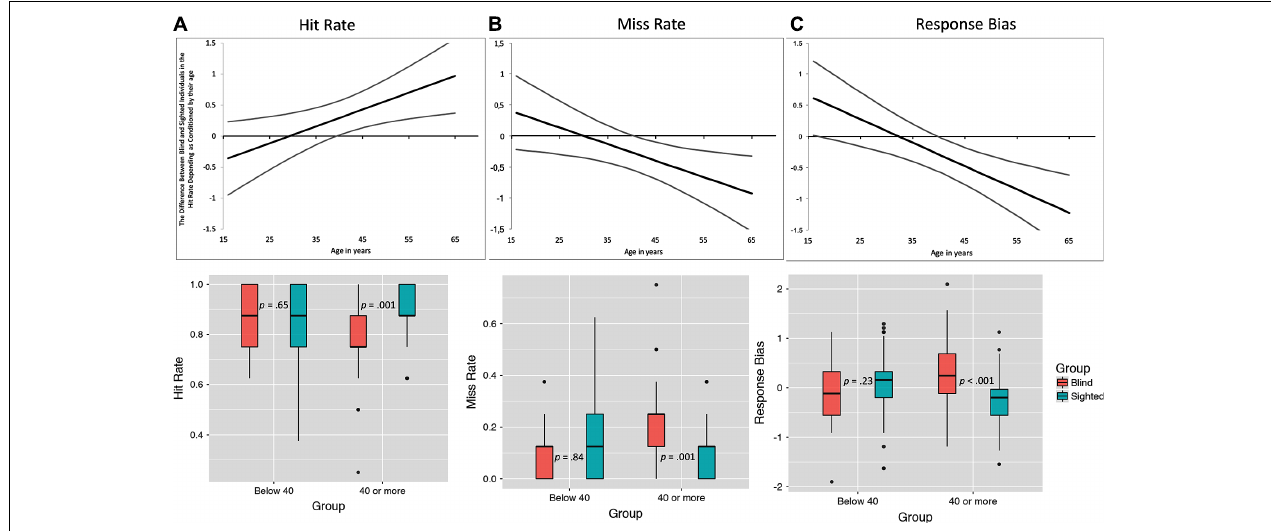
FIGURE 3 | The difference between blind and sighted individuals in hit and miss rates as moderated by their age. Top panels illustrate the zone of significant interaction estimated using the Johnson-Neyman technique. Gray lines are 95% confidence intervals – in the cases if both intervals do not cross X Axis, the moderation effect is statistically significant. Lower panels illustrate the difference between blind and sighted individuals below and above the age levels estimated using Johnson-Neyman method. All values are estimated with the covariates (gender, age, and verbal memory) being partialled-out. Error bars denote standard errors.